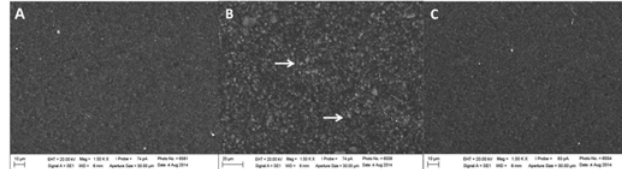
Fig. 3. SEM images of the surface morphology for the Filtek Z350XT Flow group (1500 X): (A) baseline; (B) after erosive challenge and (C) after saliva immersion; ( (cid:74) ): filler particles.